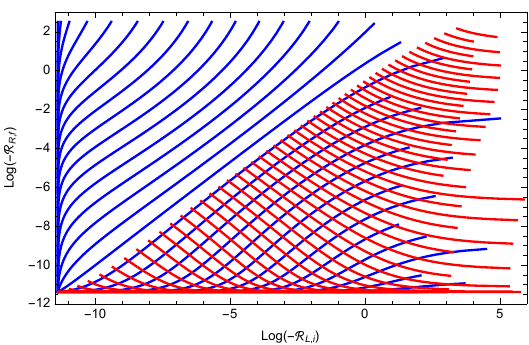
(blue curves) and type W LL Figure 40 . Type W LR 1 , 0 The curves are demonstrated for different constant values of ϕ